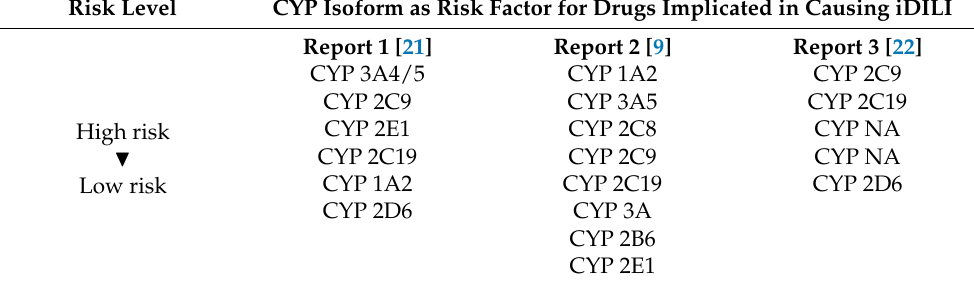
Table 4. Listing of CYP isoforms as risk factors for drugs implicated in causing iDILI. Data are derived from published reports [9,21,22]. Some cases of iDILI were assessed for causality using RUCAM [21,22], others were not assessed [9]. Abbreviations: CYP, Cytochrome P450; iDILI, idiosyncratic drug induced liver injury; NA, not available; RUCAM, Roussel Uclaf Causality Assessment Method. Risk Level CYP Isoform as Risk Factor for Drugs Implicated in Causing iDILI Report 1